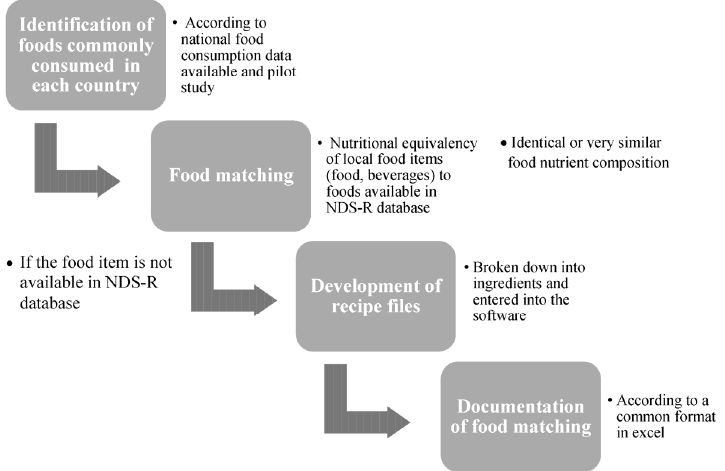
Figure 1. Standardized food matching procedure applied across Latin American Study of Nutrition and Health (ELANS) countries.